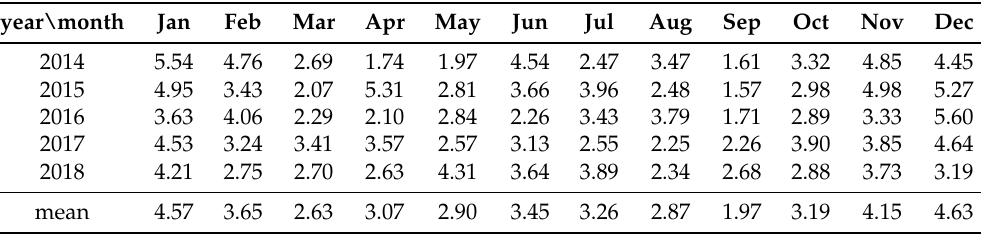
Table A13. Monthly means for currents for the years